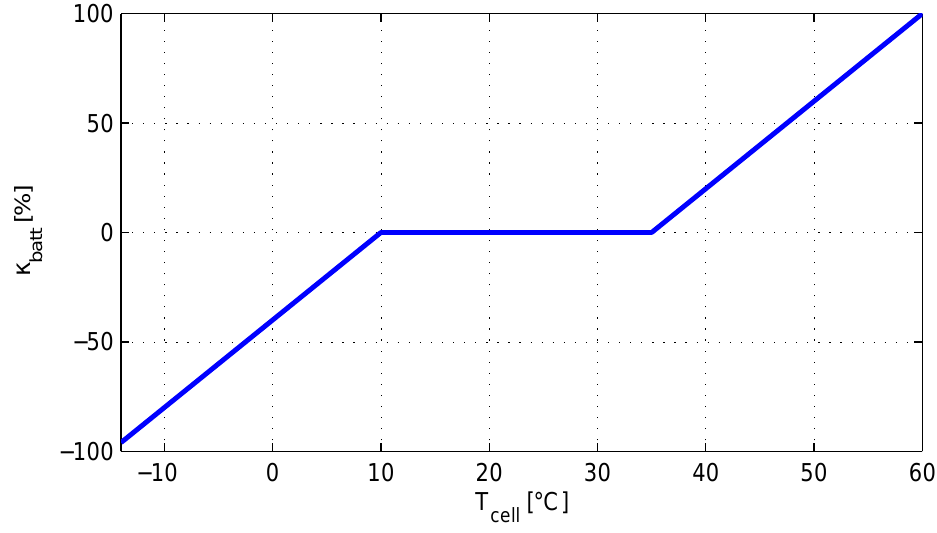
versus cell batt